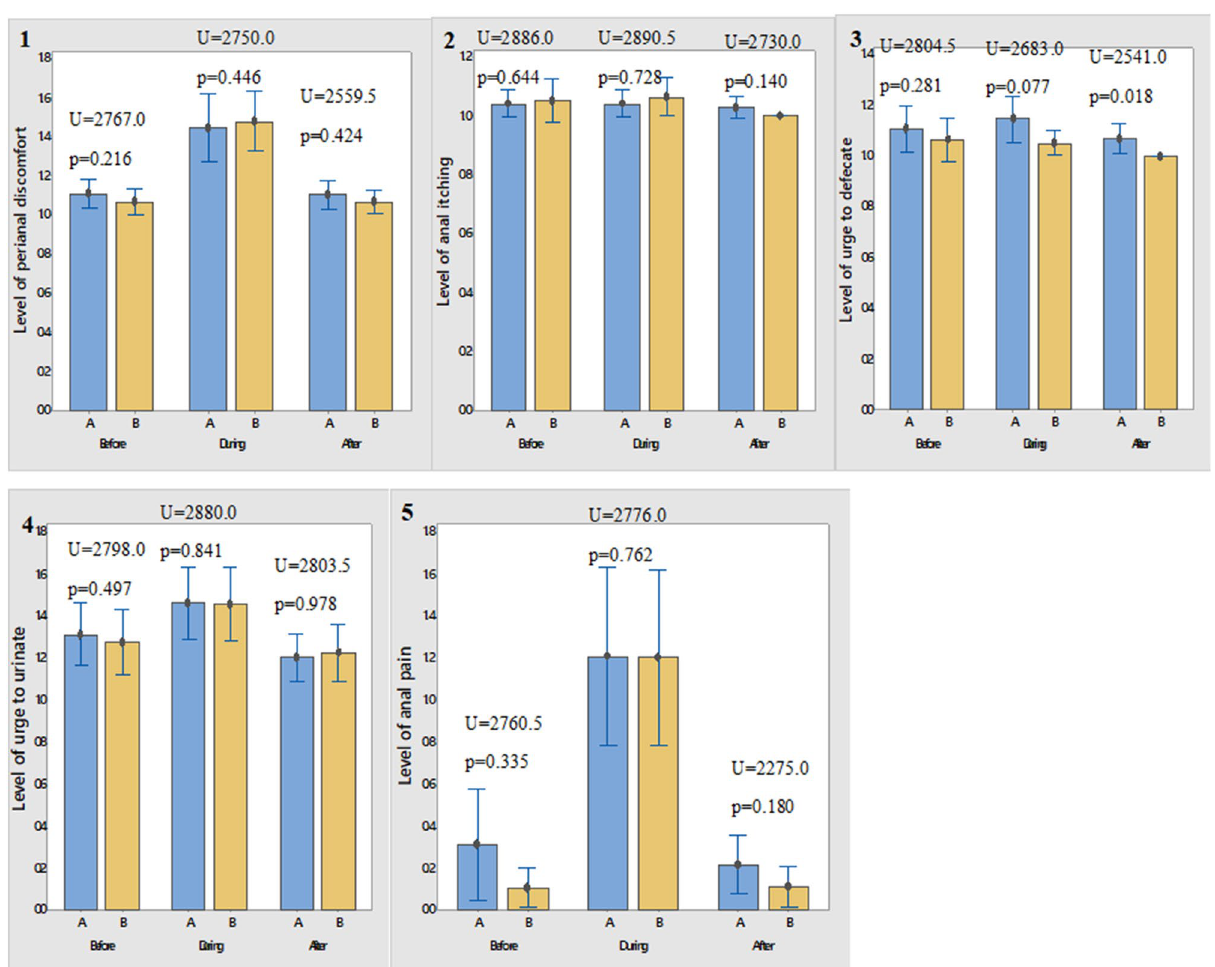
Figure 3. Differences in adverse effect before, during and 30 min after DRE for shea lubricant versus lidocaine